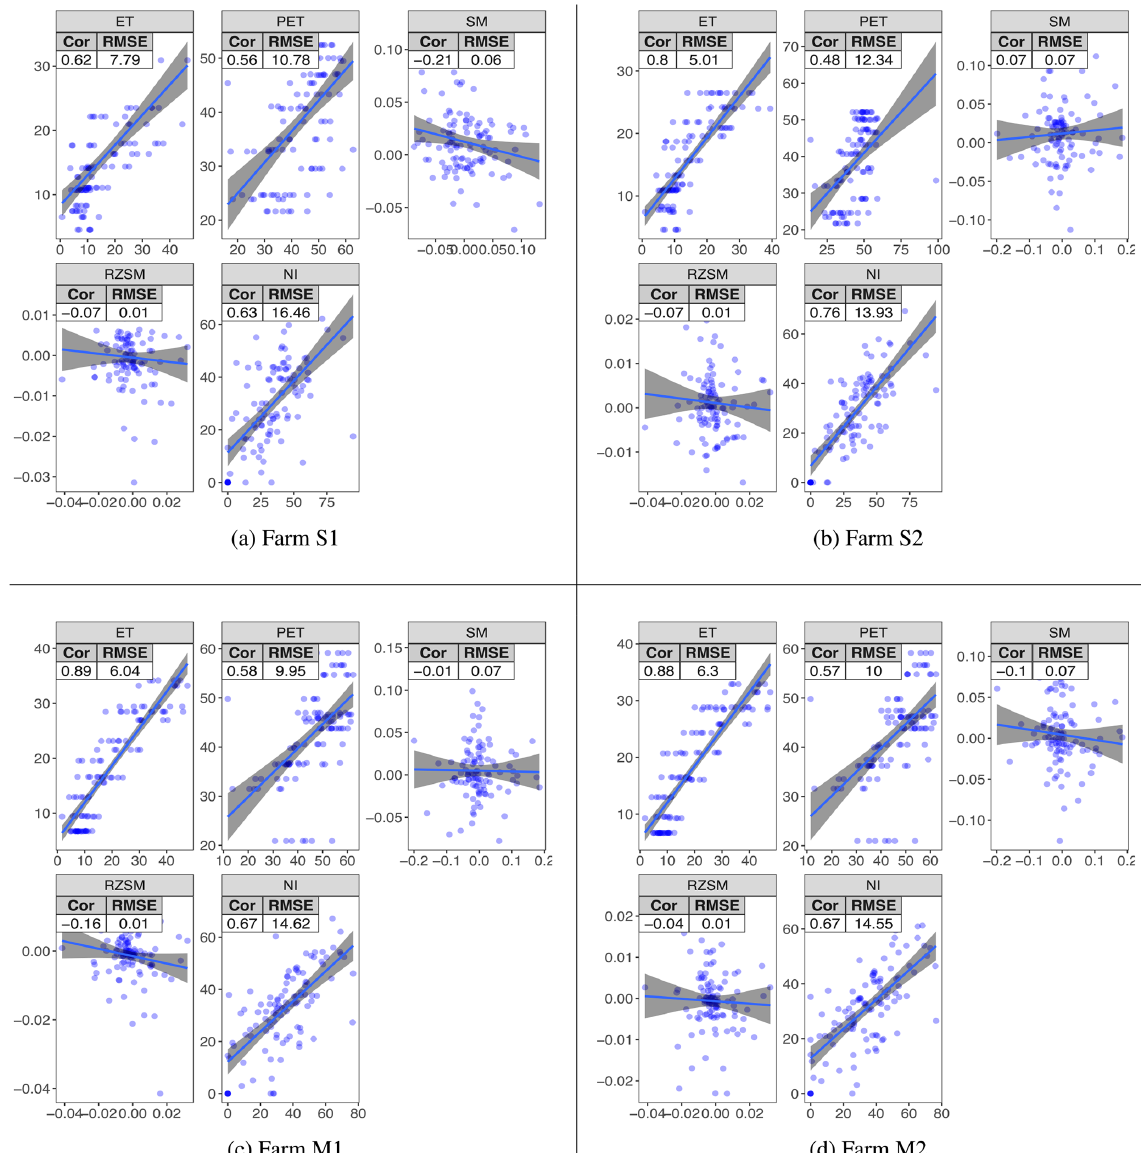
Figure 9. The 8d correlation and RMSE plots for agricultural periods of Farms S1, S2, M1, and M2 (2015–2020). Horizontal axes show observed values. Vertical axes are predicted. Note that the predicted NI is indirectly calculated from all the predicted variables. The crop is barley for the duration of 150d of planting each year. Gray shades aid the eye in seeing linear patterns using a lm smoothing